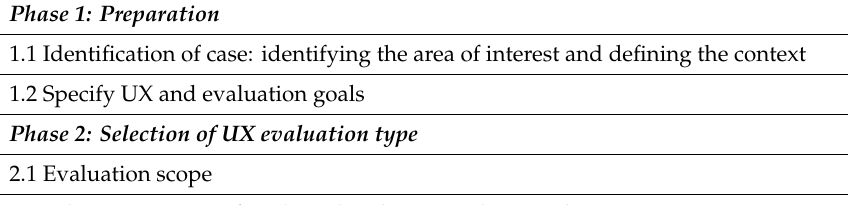
Table 1. An overview of the phase-by-phase description of the procedure for action and intention recognition in human robot interaction (ANEMONE).